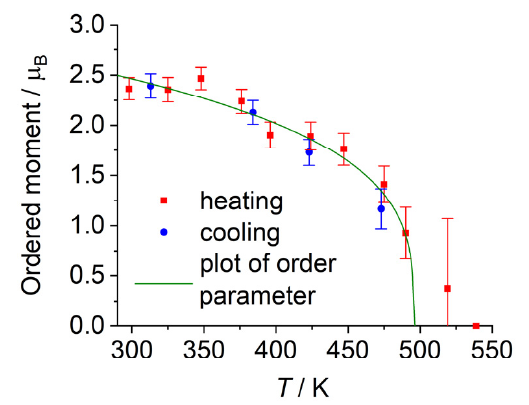
Figure 5. Temperature dependence of refined magnetic moment with fixed occupation ( SOF (Fe,1 a ) = 0.798) in ordered FePd 3 under isobaric conditions ( p (D 2 ) = 8.2(2) MPa) based on in situ neutron powder diffraction data (see Figure 3). Green line shows the fitted function of the model of second- (cid:2868).(cid:2870)(cid:2876)((cid:2873)) (cid:16) 495 ( 8 ) K − T (cid:17) 0.28 ( 5 ) (cid:2872)(cid:2877)(cid:2873)((cid:2876)) (cid:3012) (cid:2879) (cid:3021) (cid:4673) ). order phase transition ( µ ord . . = 3.2 ( 2 ) µ B